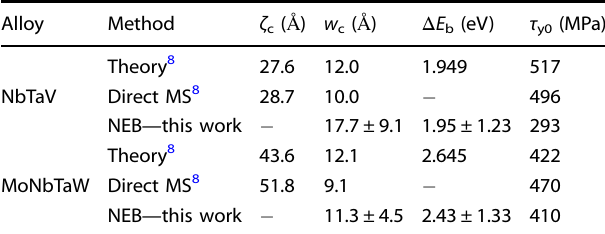
Fig. 1 Solute/edge dislocation interaction energies (in meV). Nb solutes and V solutes in the average-atom NbTaV alloy (top row), Mo solutes and Ta solutes in the average-atom MoNbTaW alloy (bottom row). Table 1. Characteristic length scale and energy barrier, mean( ⋅ ) ± standard deviation( ⋅ ) of the corresponding distributions, as measured by direct NEB simulations and as predicted by theory 8 for two model